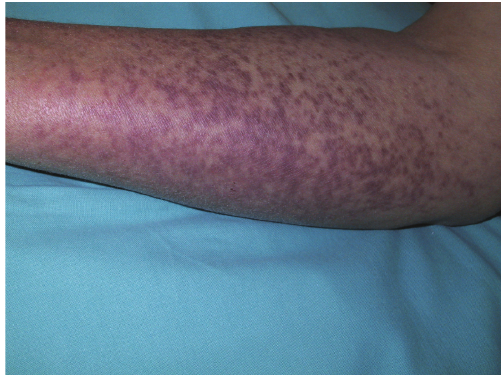
Figure 1: Papular, purplish cutaneous lesions of urticaria pigmen- tosa on the forearms.